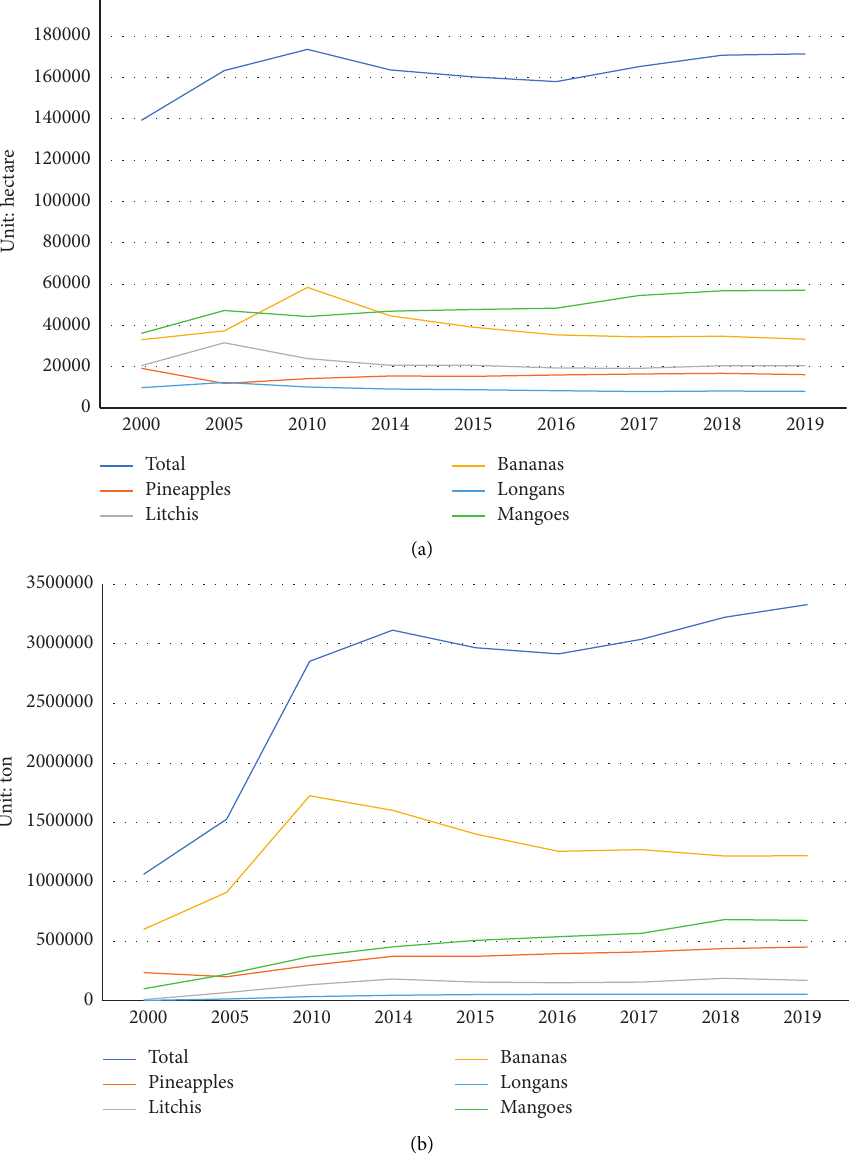
Figure 3: Total cultivated areas and output of Hainan’s fruits.